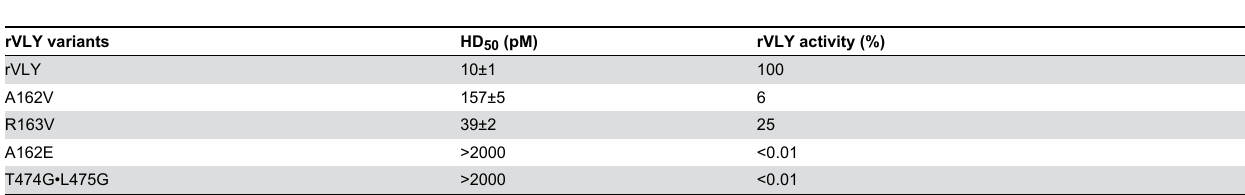
Table 1. Hemolytic activity of rVLY mutants.